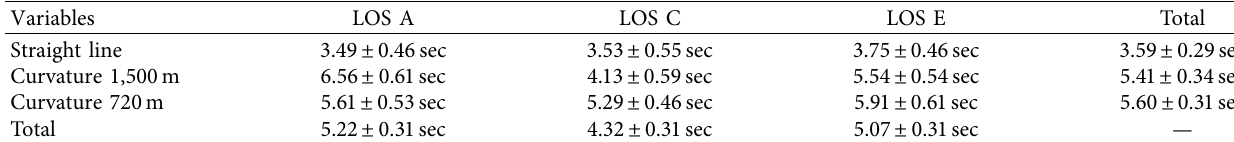
Table 11: Stabilization times by LOS and curvatures.